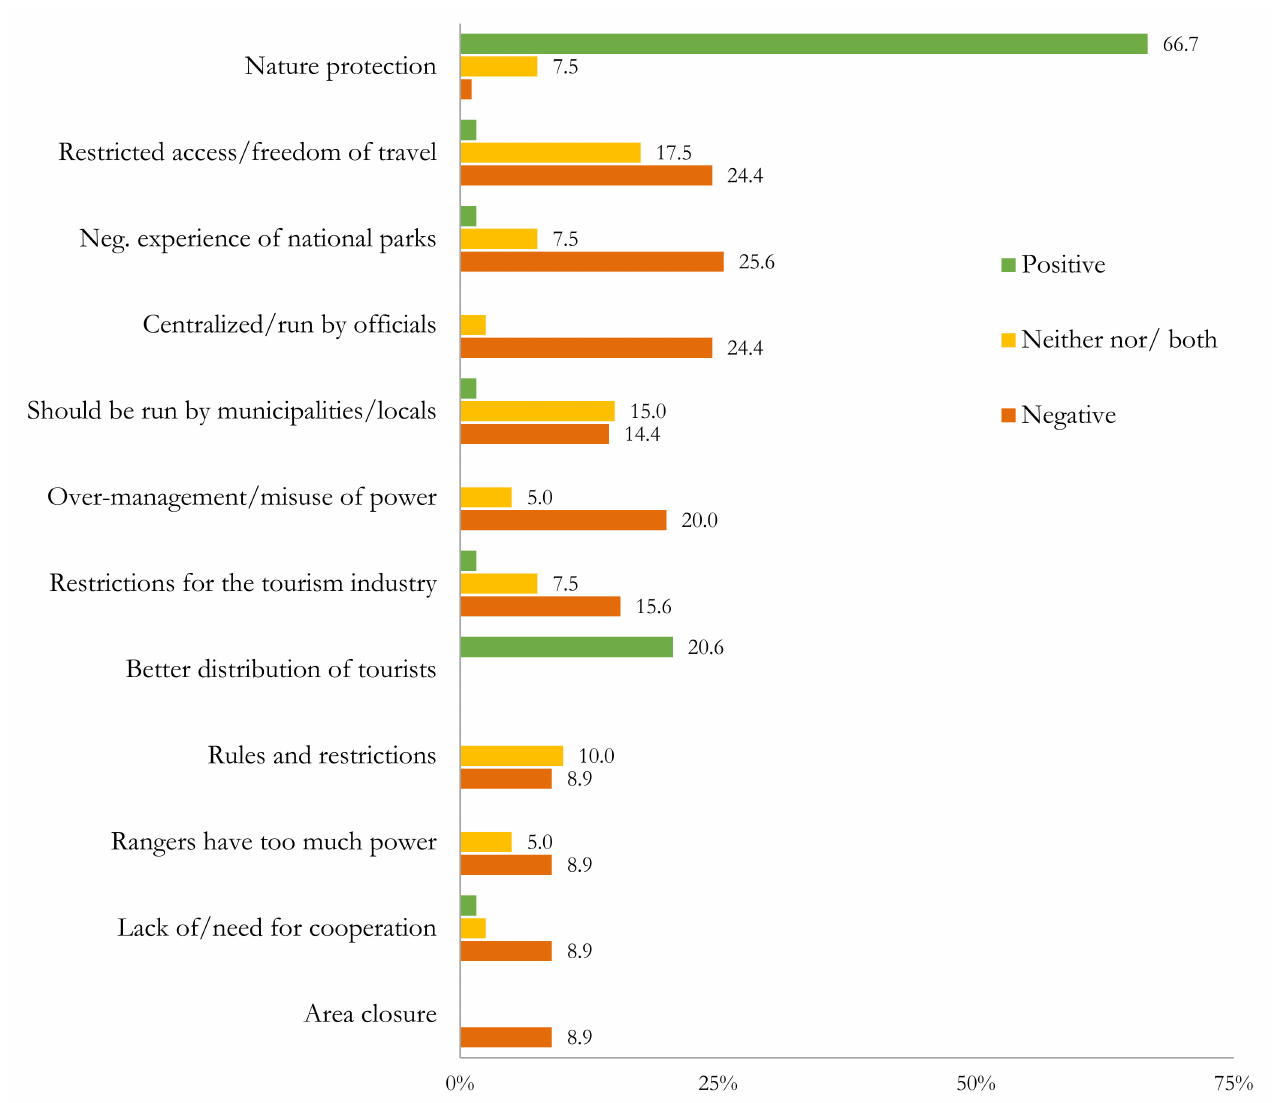
Figure 6. Reasons for the tourism industry attitudes towards the Central Highlands National